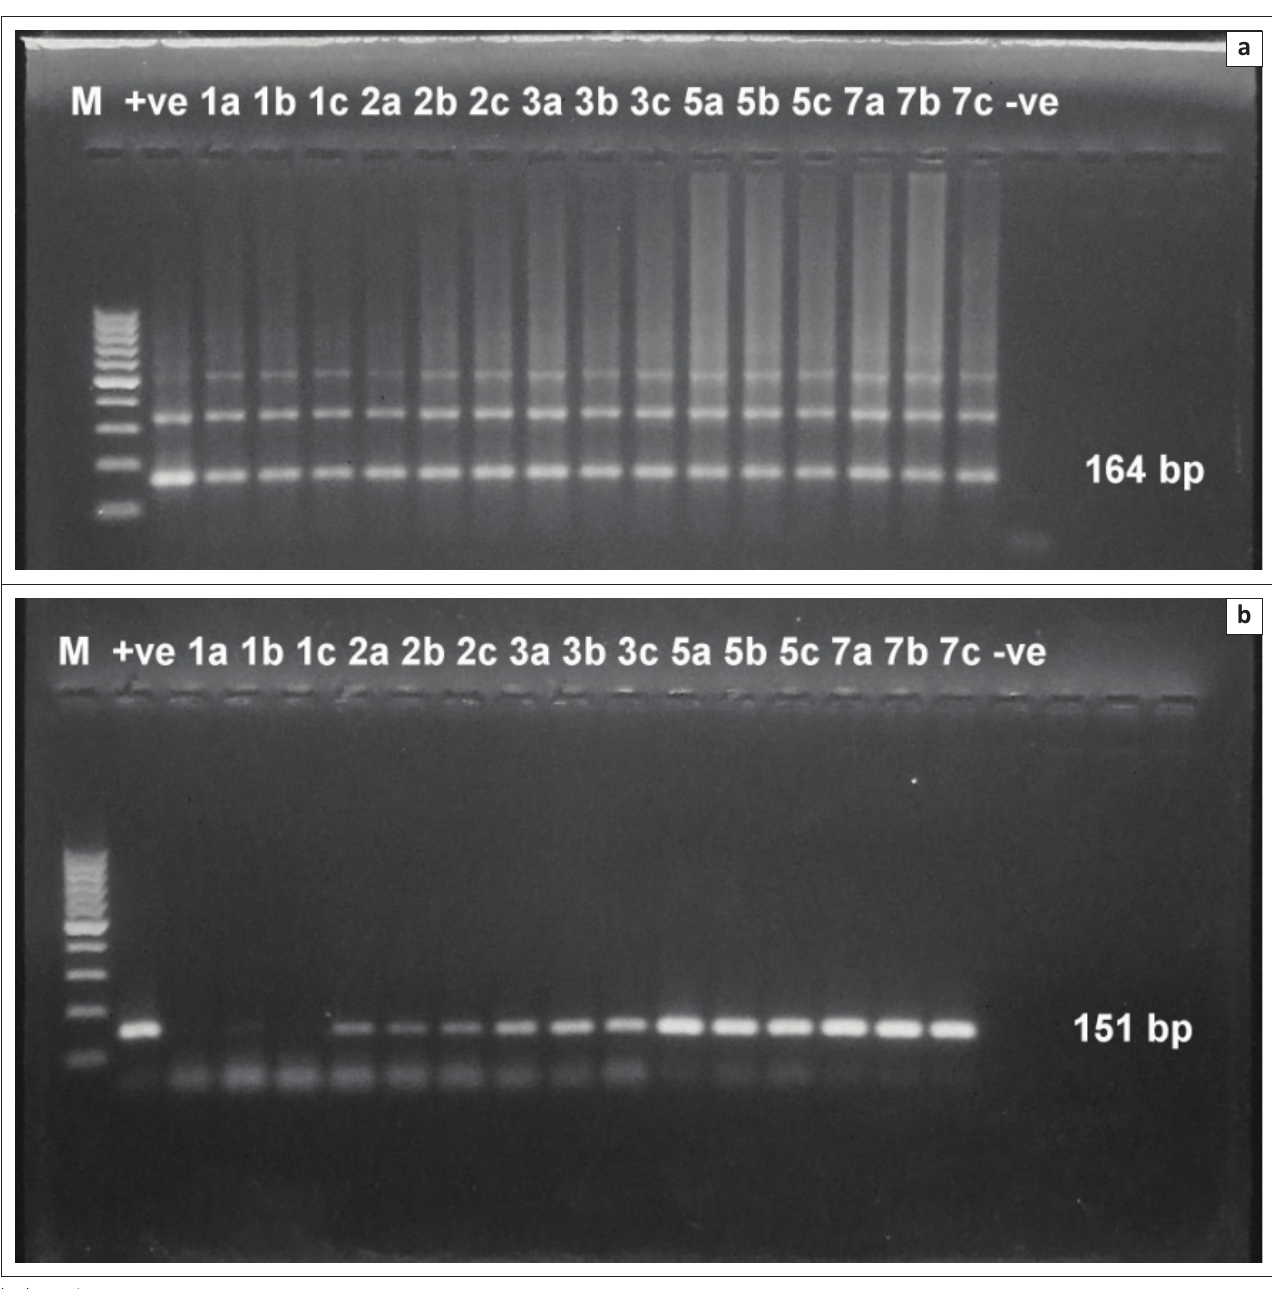
FIG URE 4: Direct polymerase chain reaction from mouse injected with 10 2 trypanosome. (a) Polymerase chain reaction amplification using Trypanosoma brucei 1/2 primer sets. (b) Polymerase chain reaction amplification using T. evansi Rode Trypanozoon antigen type 1.2 primer sets. M: 100 base pair molecular weight Deoxyribonucleic acid marker, +ve: positive control, -ve: negative control, Numbers: days post infection. Letters: mice were sacrificed at day 1, 3, 5 and 7 post